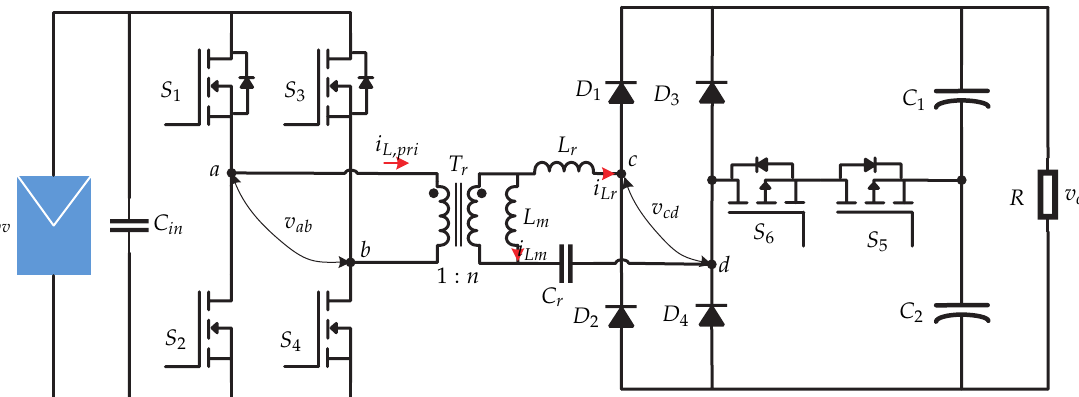
Figure 18. Microinverter’s topology proposed in [27,28].